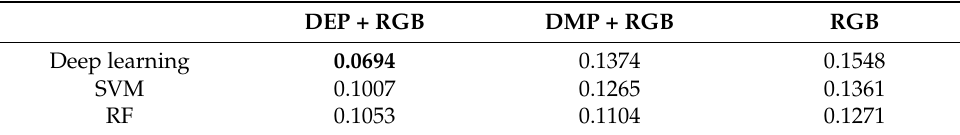
Table 5. Total disagreement for Pleiades